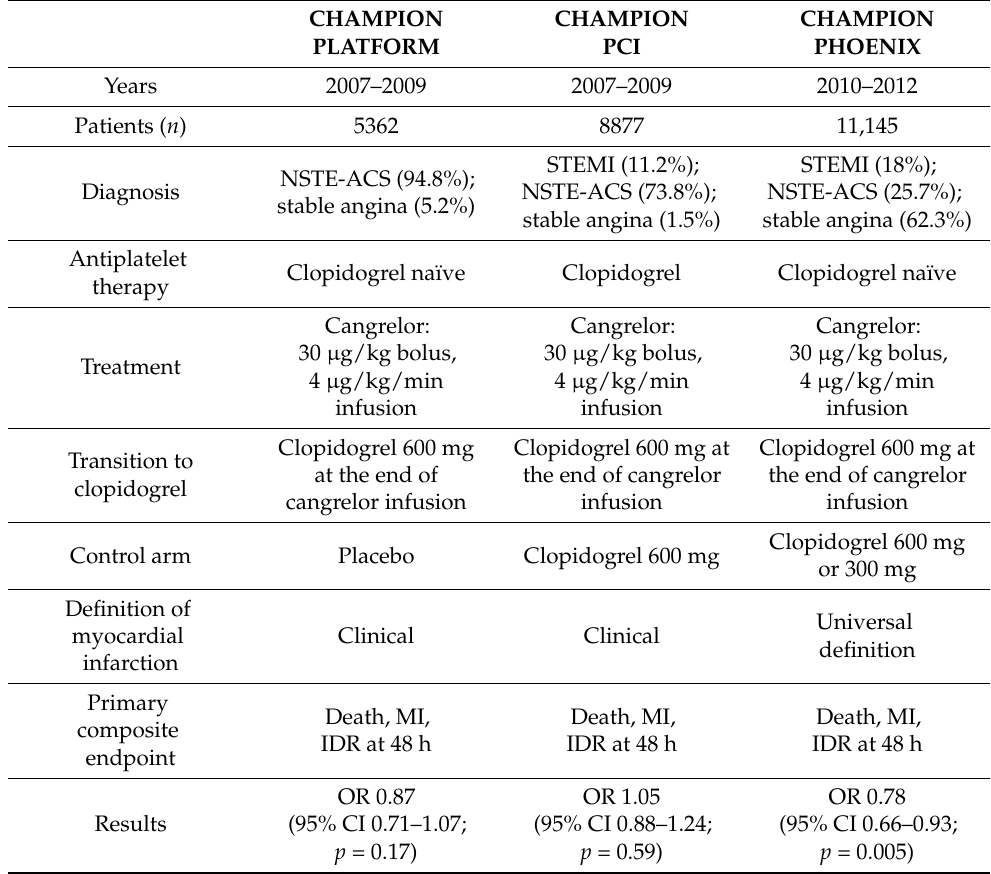
Table 1. Overview of the CHAMPION Program trials.